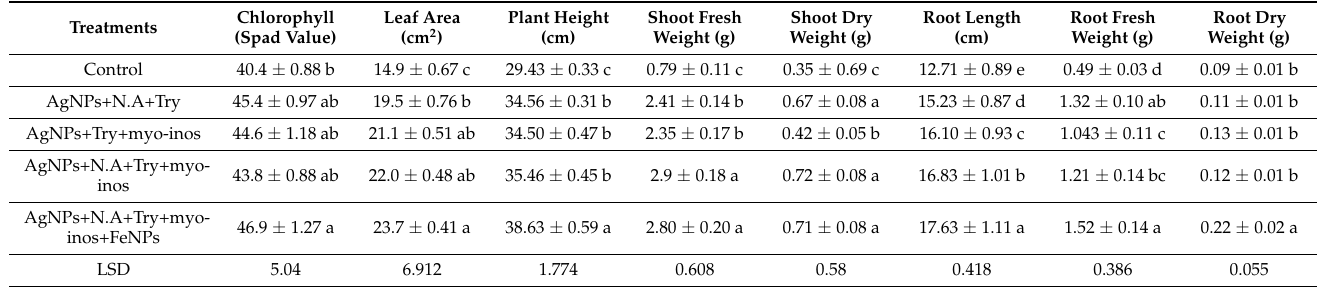
Table 1. Effect of different treatments of blended NPs on morphological attributes of